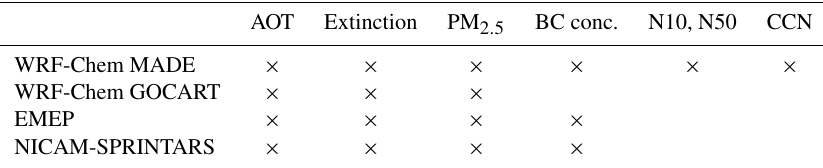
Table 2. Simulated